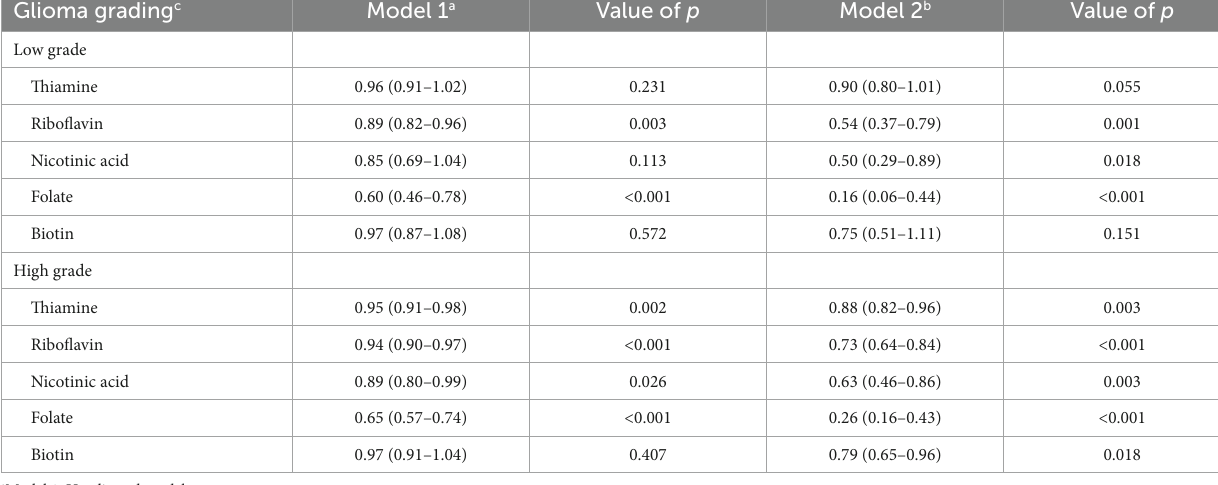
TABLE 4 Adjusted ORs and 95% CIs for the association between B vitamins and glioma of different grades. Glioma grading